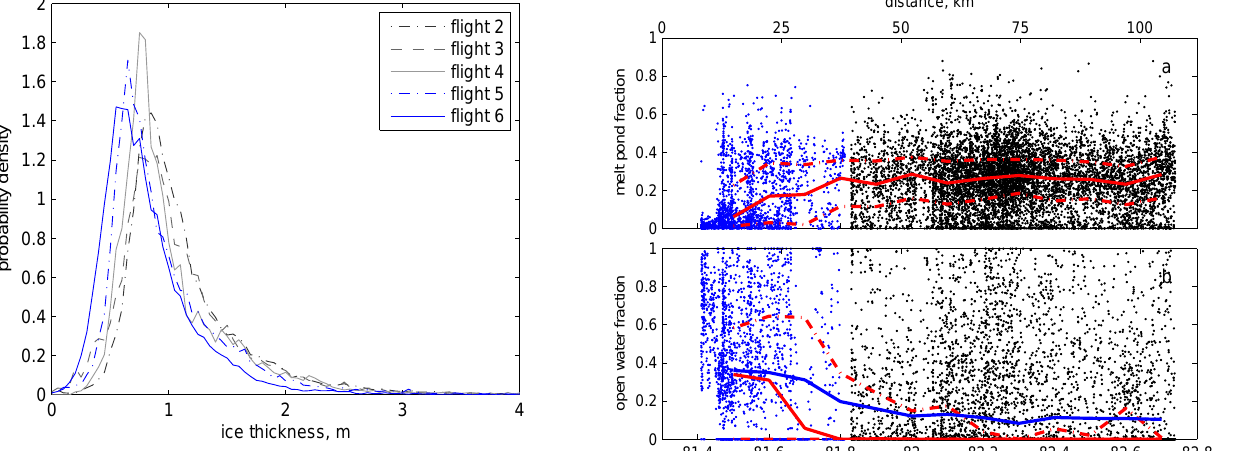
Figure 5. Probability density on sea-ice thickness for flights 2–6 derived from EM bird measurements. Figure 6. Latitudinal distribution in f i